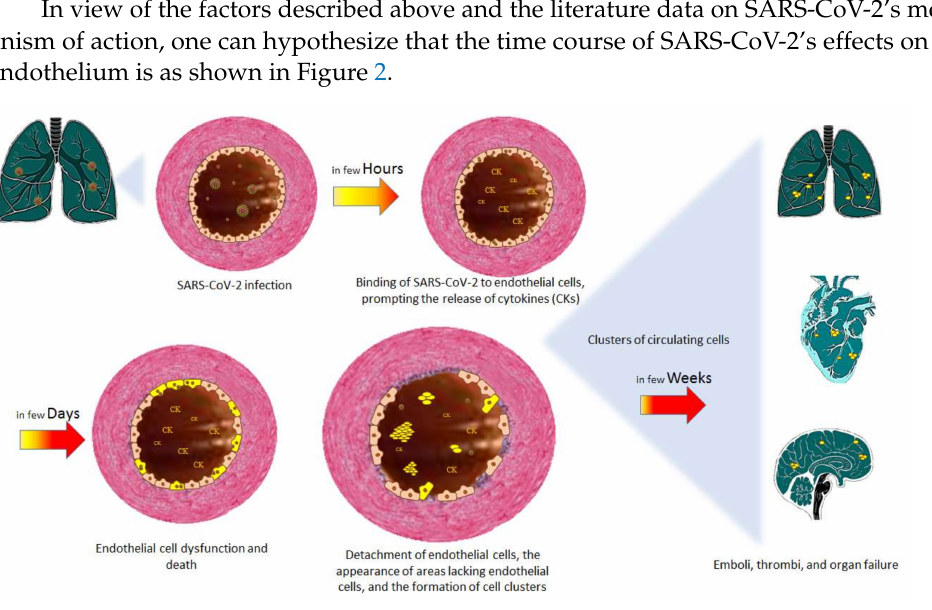
Figure 2. The time course of SARS-CoV-2 infection, the consequences for endothelial cells, and the resulting